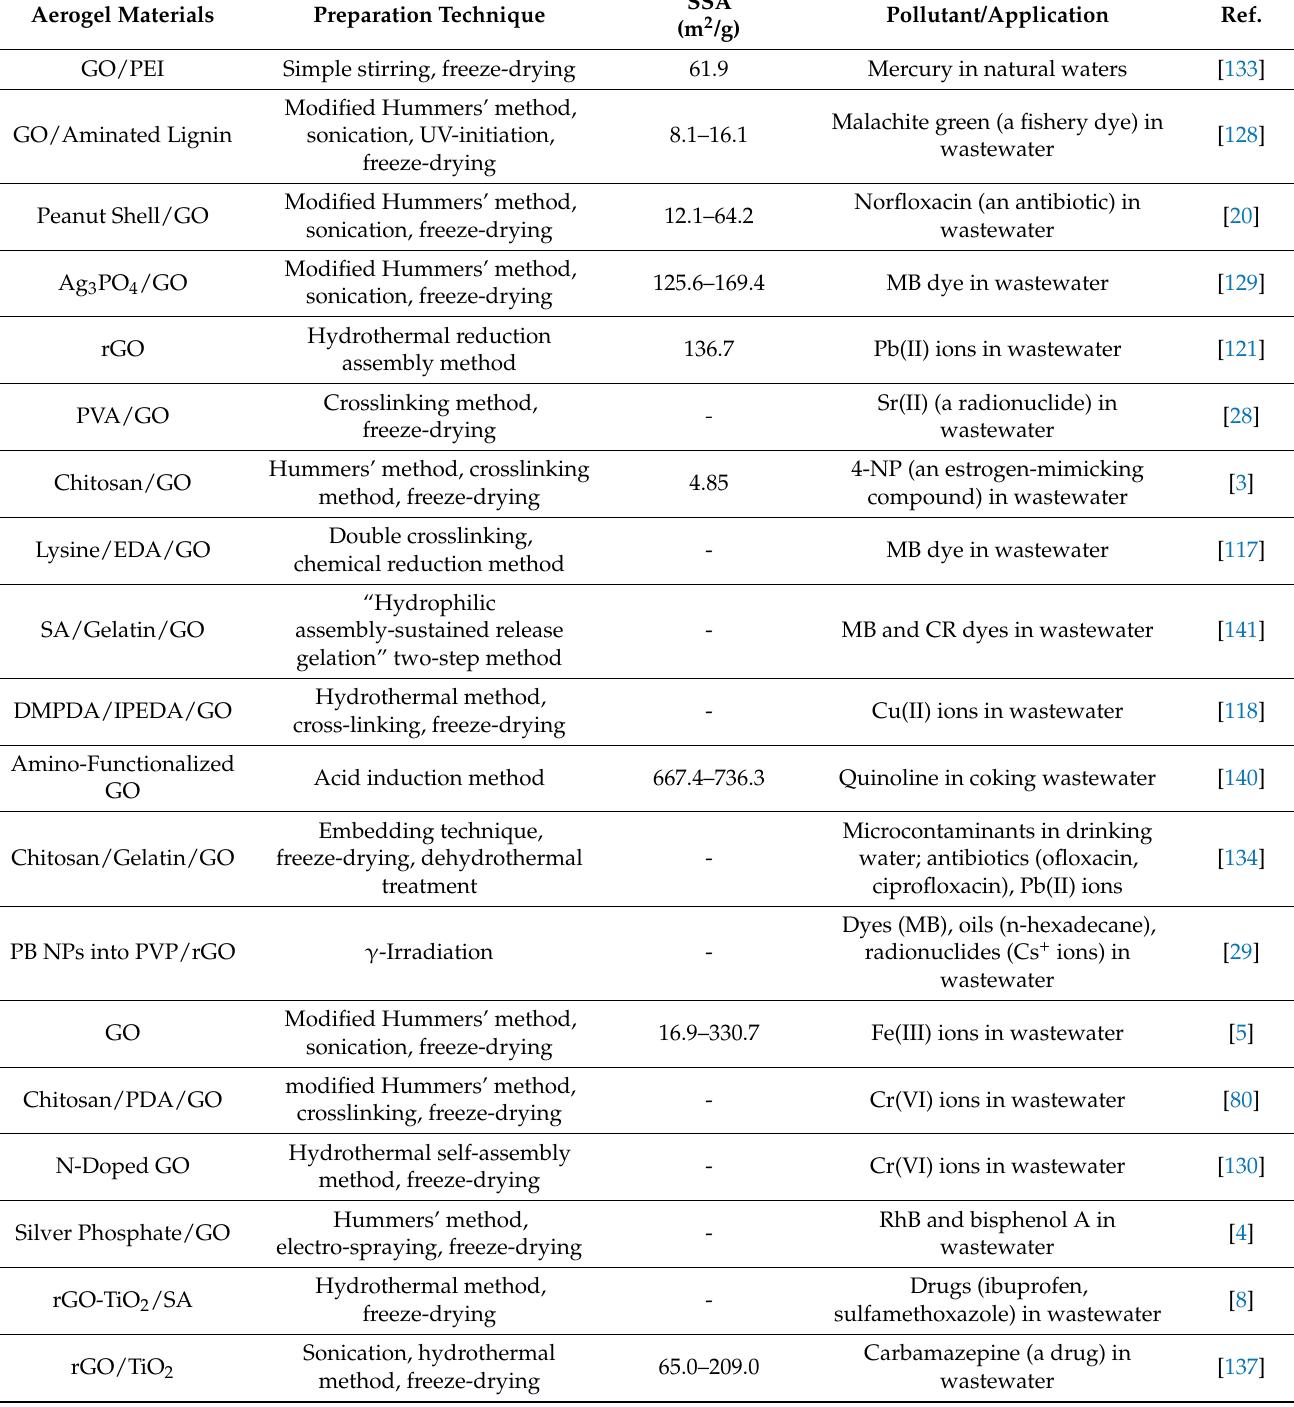
Table 4. Graphene oxide-based aerogels for water treatment. 4-NP: 4-nonylphenol; Ce 2 O 3 : cerium oxide; CMC: carboxymethyl cellulose; CR: Congo red; DMPDA: dimethylaminopropylamine; DMAC: dimethylacetamide; DMF: N,N-dimethylformamide; DMSO: dimethyl sulfoxide; EDA: ethylenediamine; GO: graphene oxide; IPEDA: N- isopropylethylenediamine; MB: methylene blue; MO: methyl orange; M1180: mineral oil; MMT: montmorillonite; Nd 2 O 3 : neodymium oxide; NPs: nanoparticles; PB: Prussian blue; PDA: polydopamine; PEI: polyethylenimine; Pr 2 O 3 : praseodymium oxide; PVA: polyvinyl alcohol; PVP: polyvinylpyrrolidone; QAS: quaternary ammonium salts; rGO: reduced graphene oxide; RhB: rhodamine B; SA: sodium alginate; SSA: specific surface area; TiO 2 : titanium oxide; ZIF-67: zeolitic imidazolate